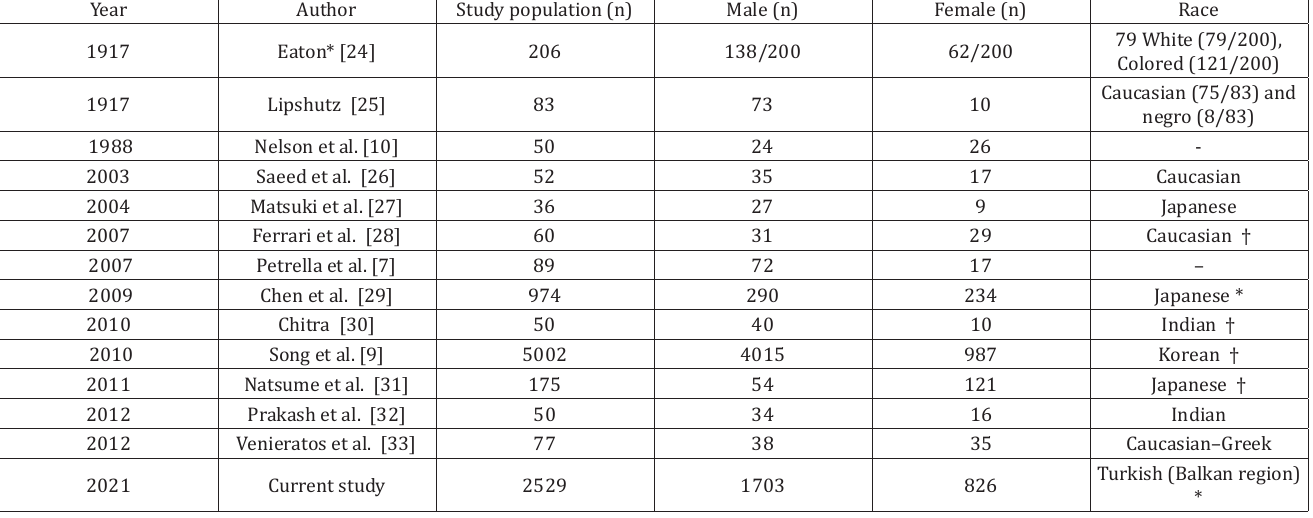
Frequency of included cases by race and gender in the literature